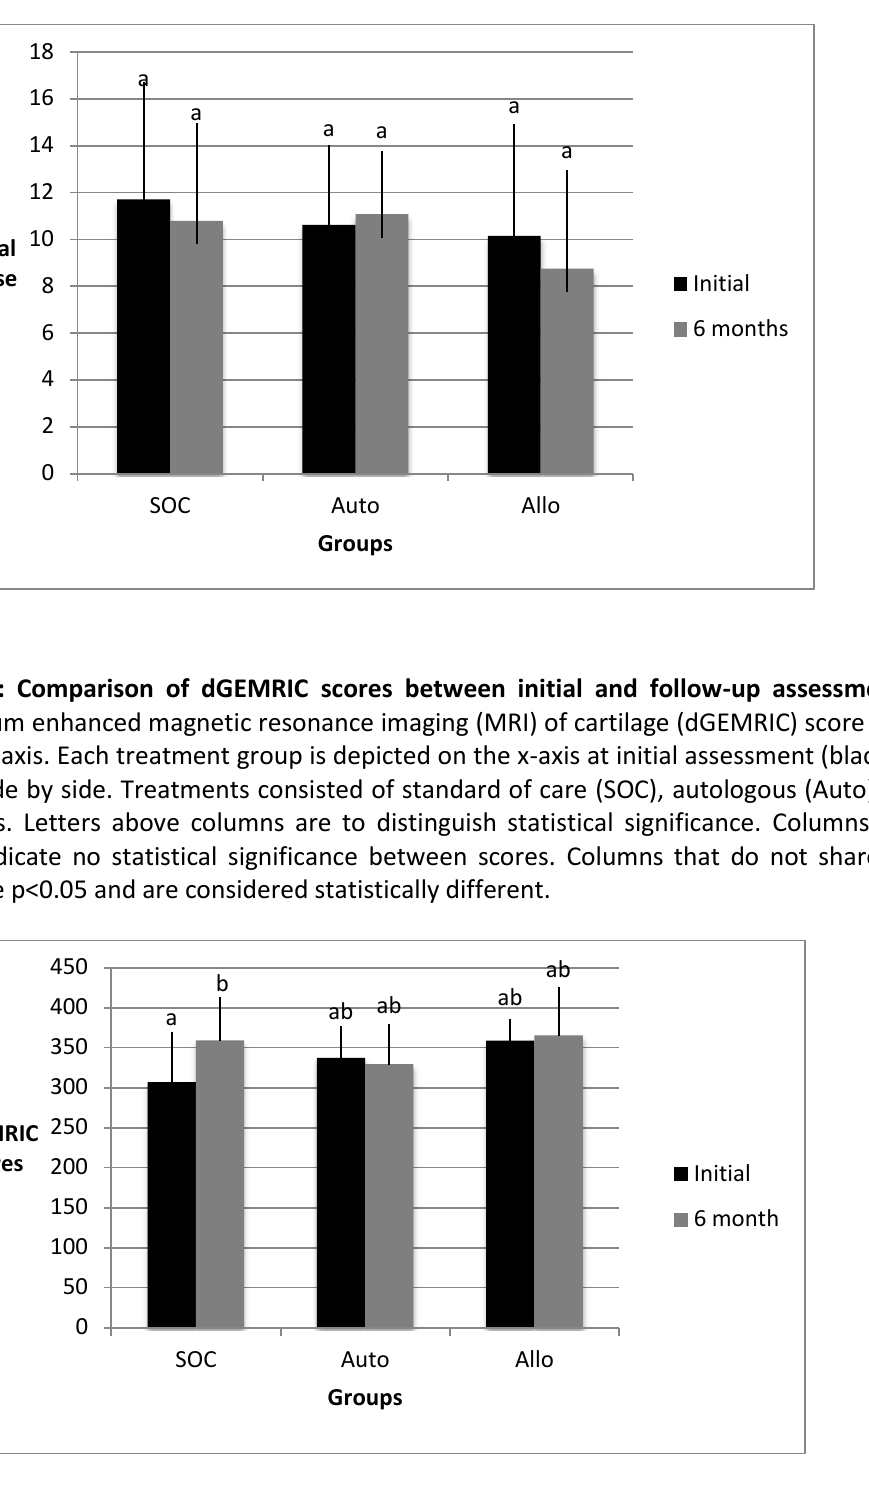
Figure 4: Comparison of peak vertical impulse between initial and follow-up assessments. Average peak vertical impulse, corrected for body weight, depicted on the y- axis, with each treatment group depicted on the x-axis. Initial assessment (black) and 6-month assessment (grey) are depicted side by side for each treatment group. Treatments consisted of standard of care (SOC), autologous (Auto) or allogeneic (Allo) cell therapies. Letters above columns are to distinguish statistical significance. Columns labeled with the same letter indicate no statistical significance between scores. Columns that do not share a common alphabetic letter are p<0.05 and are considered statistically different.